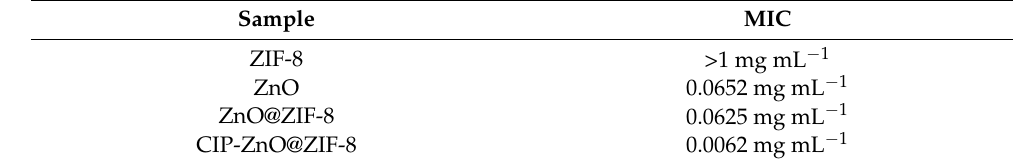
Table 2. MIC of samples against S. aureus (Gram-positive bacteria) (n = 3).